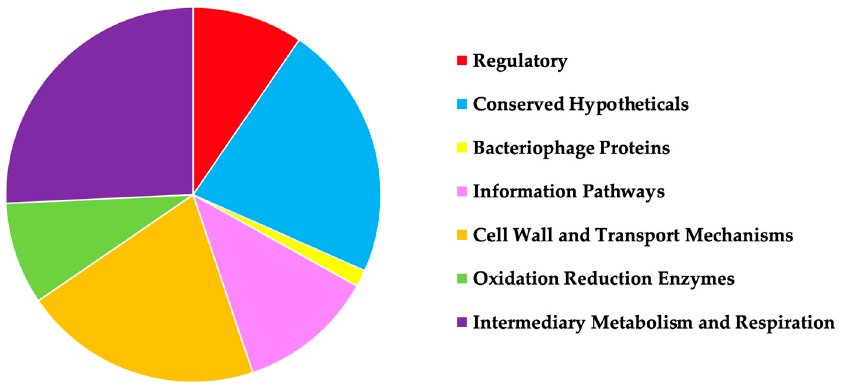
Figure 1. A pie chart displays MAB 19977 transposon mutants identified in this study that are grouped based on the protein functional classes. The gene knockout mutants were sequenced with LM-PCR, and transposon insertions were analyzed by blasting obtained nucleotide sequences (adjacent to the transposon) against the reference genome of MAB 19977. The gene domains/motifs of the putative proteins were analyzed using the CD-Search tool available at NCBI and by aligning proteins to the well-characterized genome of M. tuberculosis H37Rv. Table 3. The selected MAB 19977 gene knockout mutants of cell wall transport systems associated with an increased (BC) or decreased (MIC) susceptibility to antibiotics.